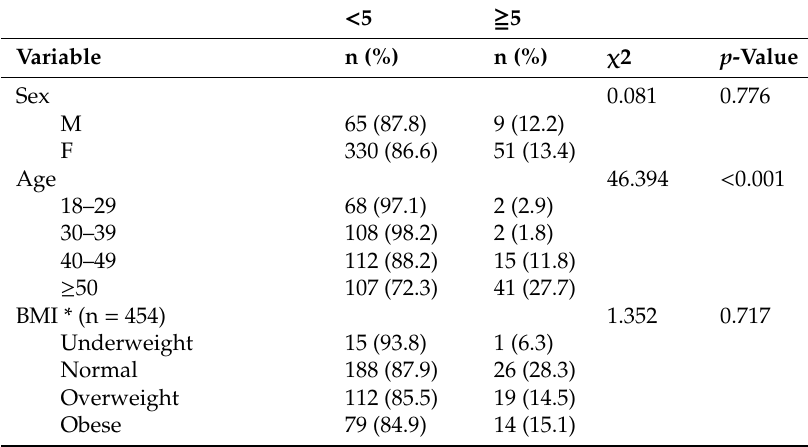
Table 4. Univariate analysis of demographic data and osteoporosis risk (n = 455). <